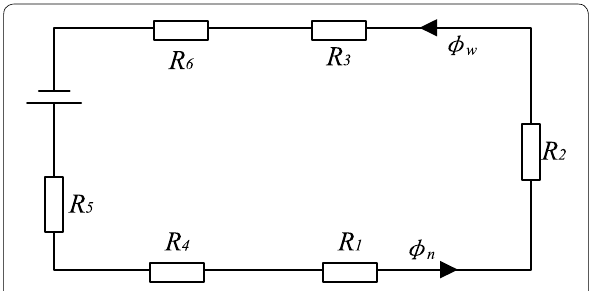
Figure 4 Dynamic equivalent magnetic circuit model of